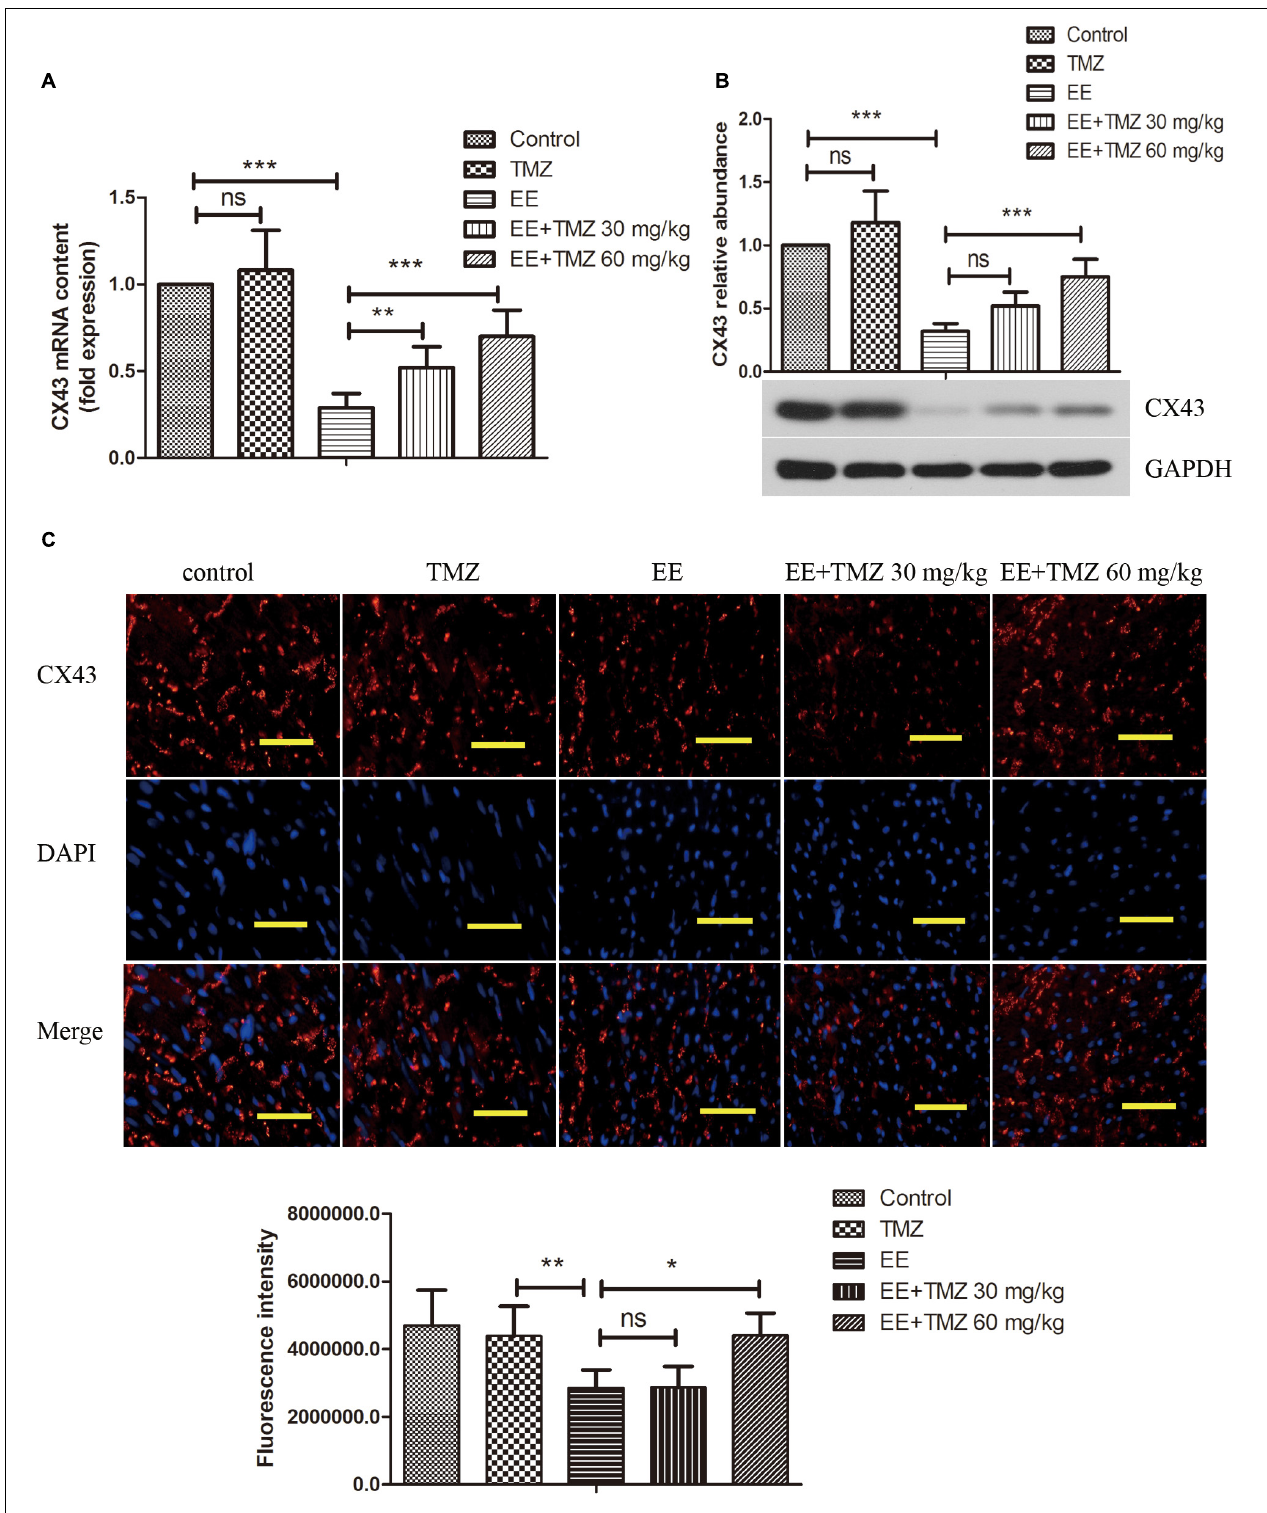
FIGURE 4 | Trimetazidine suppressed EE-induced change in the expression of connexin 43 (CX43) in myocardial tissues of rats. The mRNA and protein level of CX43 was determined by real-time PCR (A) , and western blot (B) . The expression and distribution of CX43 in myocardial tissues were observed by immunofluorescence staining (C) . Scale bar is 50 µ m. Each value is shown as mean ± SD ( n = 6). ∗ P < 0.05, ∗∗ P < 0.01, ∗∗∗ P < 0.001, versus the indicated group.